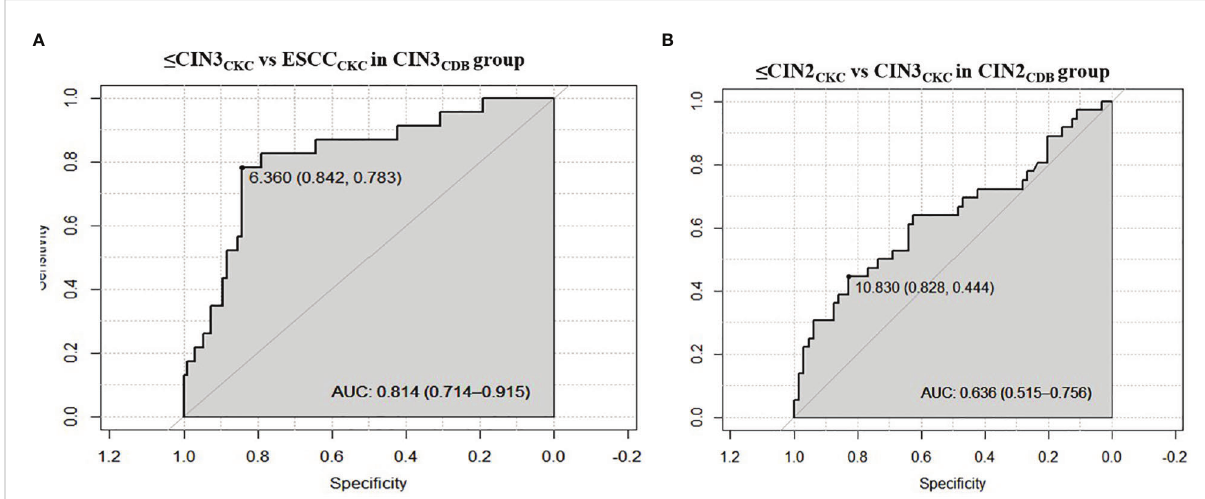
FIGURE 2 Receiver operating characteristic curves of performance of PAX1 methylation. (A) The optimal D Cp PAX1 cut-off value in predicting whether CIN3 would be upgraded to ESCC after CKC; (B) The optimal D Cp PAX1 cut-off value in predicting whether CIN2 would be upgraded to